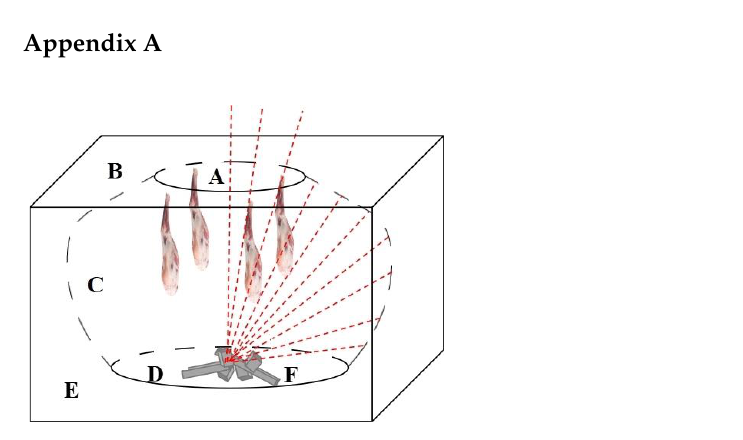
Figure A1. The diagrammatic drawing of Nang roasted lamb oyster cuts. A: Nang pit vent, B: platform, C: side of Nang pit, D: bottom of Nang pit, E: outer shell, F: heat source, red dotted line: thermal radiation.